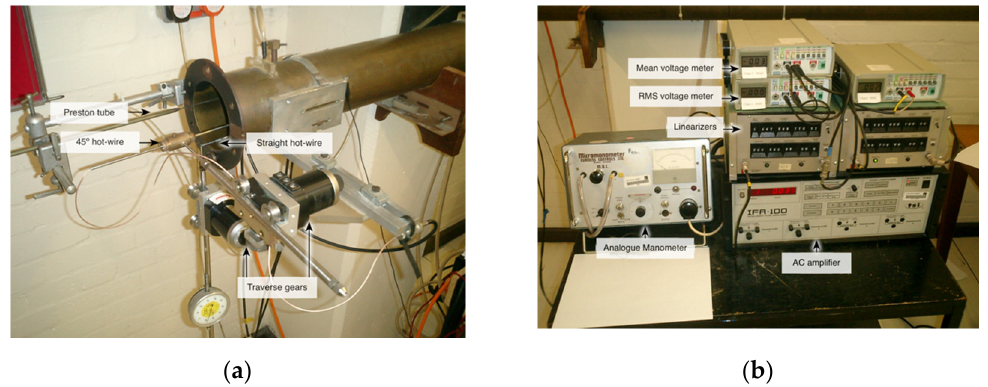
Figure 1 . Test rig for the study of fully developed turbulent flow in a pipe: ( a ) Equipment at the pipe exit; ( b ) Digital devices used in this experiment.